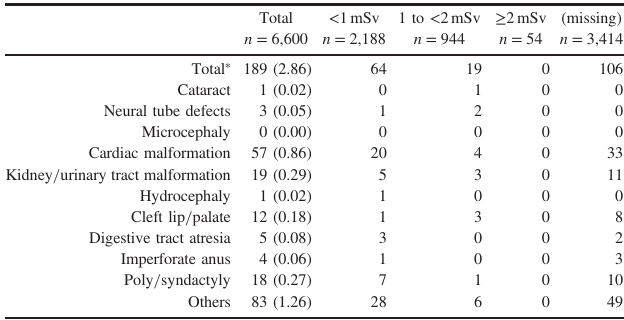
Table 4. Congenital anomalies ( n =